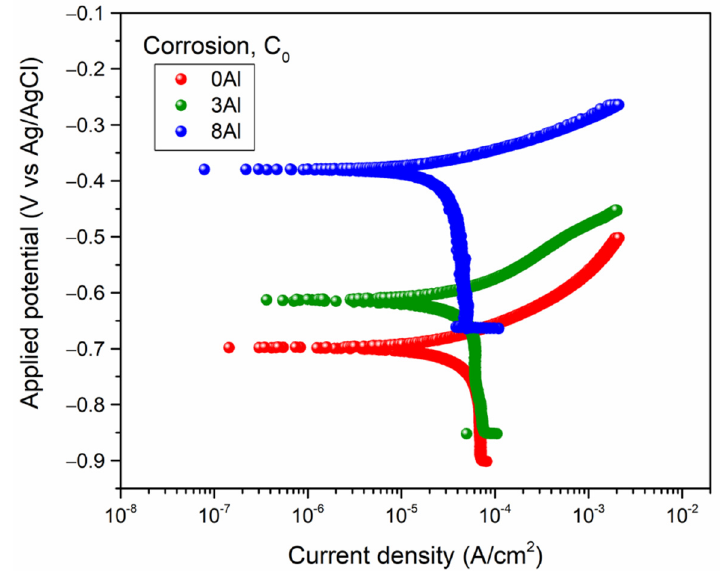
Figure 5. Polarization curves for the alloys corresponding to C 0 tests. Table 5. Corrosion potential values (compared to the Ag/AgCl reference electrode) and corrosion rates of the materials.